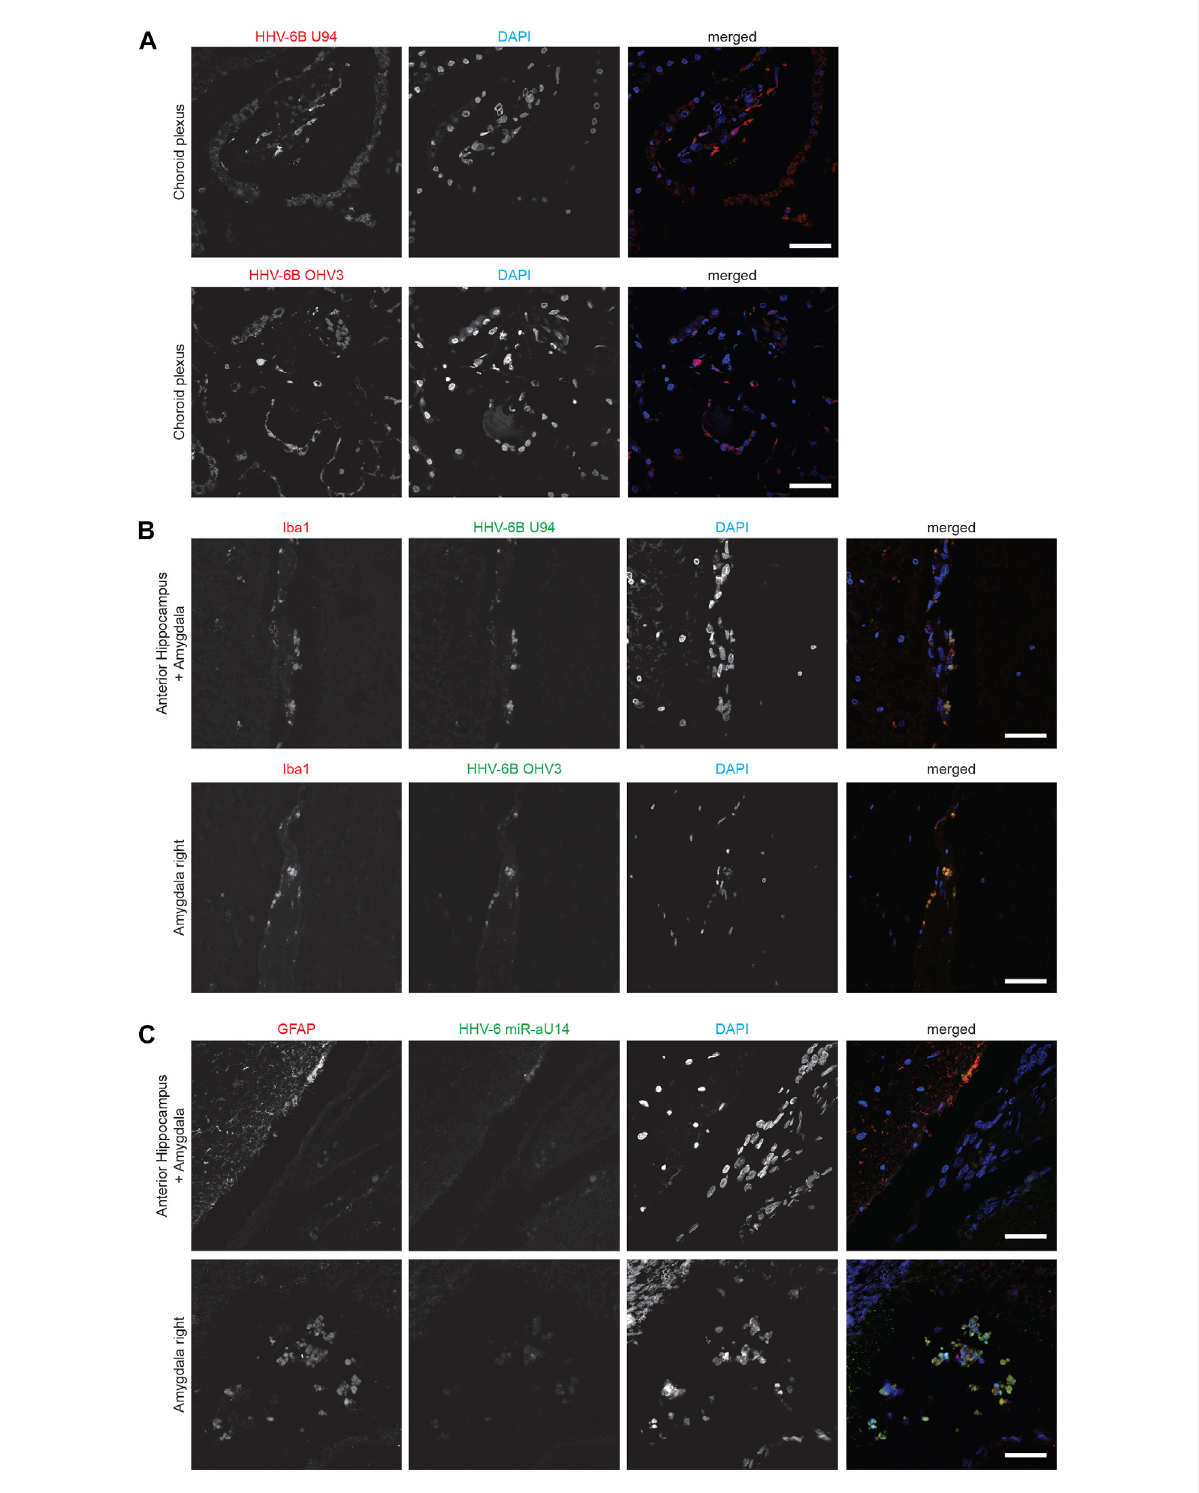
FIGURE 1 Representative fl uorescence microscopy images of different human brain tissue types of ME/CFS patients. Tissues were co-stained with antibodies against HHV-6 speci fi c proteins and/or neuronal tissue-speci fi c marker and counter-stained for DAPI. (A) Human Choroid plexus tissues co-stained for HHV-6B U94 or OHV3, respectively. For each Panel images from the left to the right show markers for HHV-6 infection (red) and cell nucleistainedbyDAPI(blue)andanoverlayoftheimages. (B) HumananteriorHippocampusandAmygdalatissuesco-stainedforIba1,HHV-6B